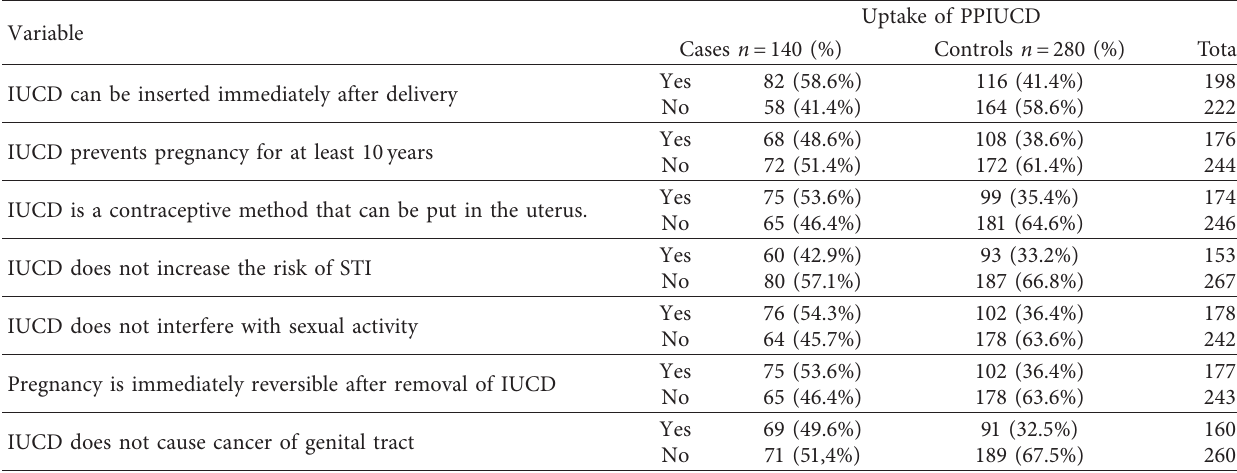
Table 4: Knowledge about PPIUCD among respondents delivering in public hospitals of South Gondar zone, Northwest Ethiopia, December 2019 ( n � 140 cases and 280 controls).